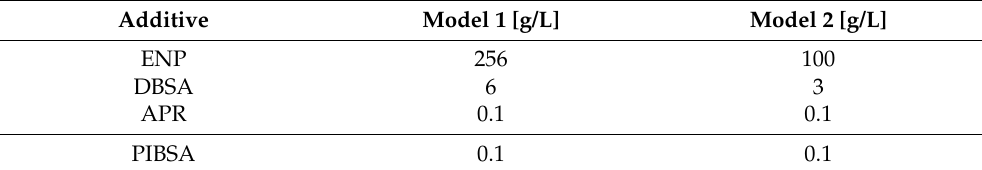
Table 4. Concentration of inhibitor/dispersant where both model systems remain stable (no asphal- tene aggregation or sedimentation detected).